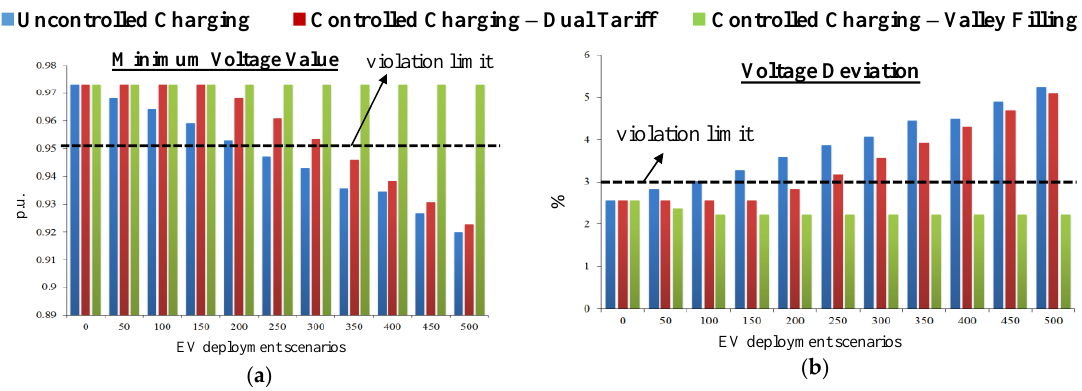
Figure 9. Voltage values for various EV penetration scenarios in the island of Ikaria (a 1 MW wind generator is considered to operate in the island for the scenarios examined): ( a ) minimum voltage value and ( b ) voltage deviation [48].